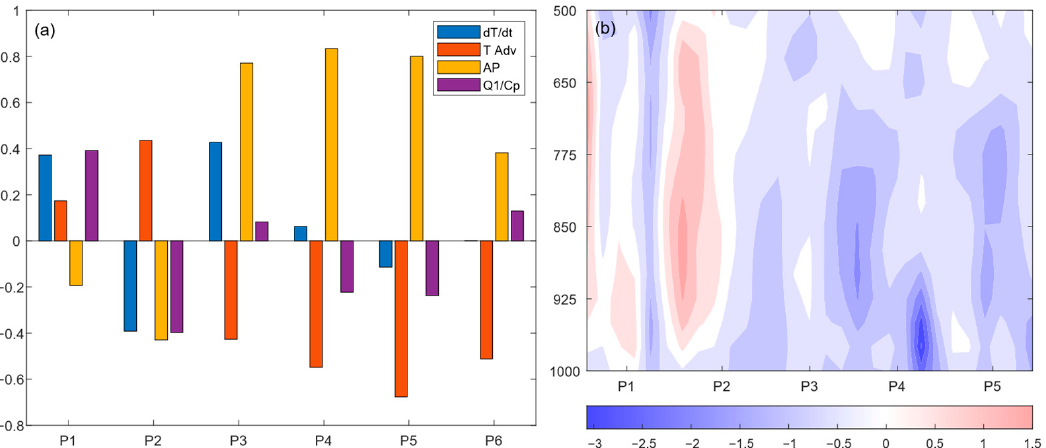
to vertical movement, and diabatic heating, respectively (K/day). ( b ) Temperature advection (shading; K/day) in P1–5 over South